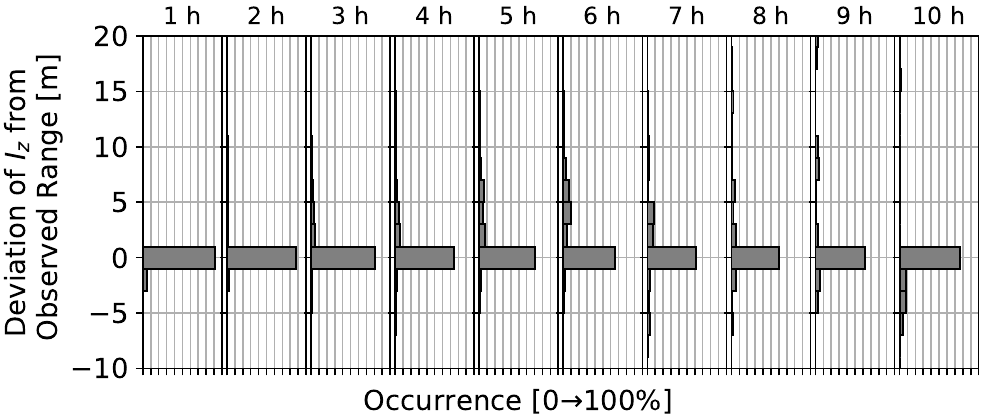
Figure 6. Deviation of estimated I z from the observed range for 238 shallow radiation fog events observed at the CESAR facility between April 2011 and September 2020. The PDFsshow the difference in 2 m bins, over each hour after fog